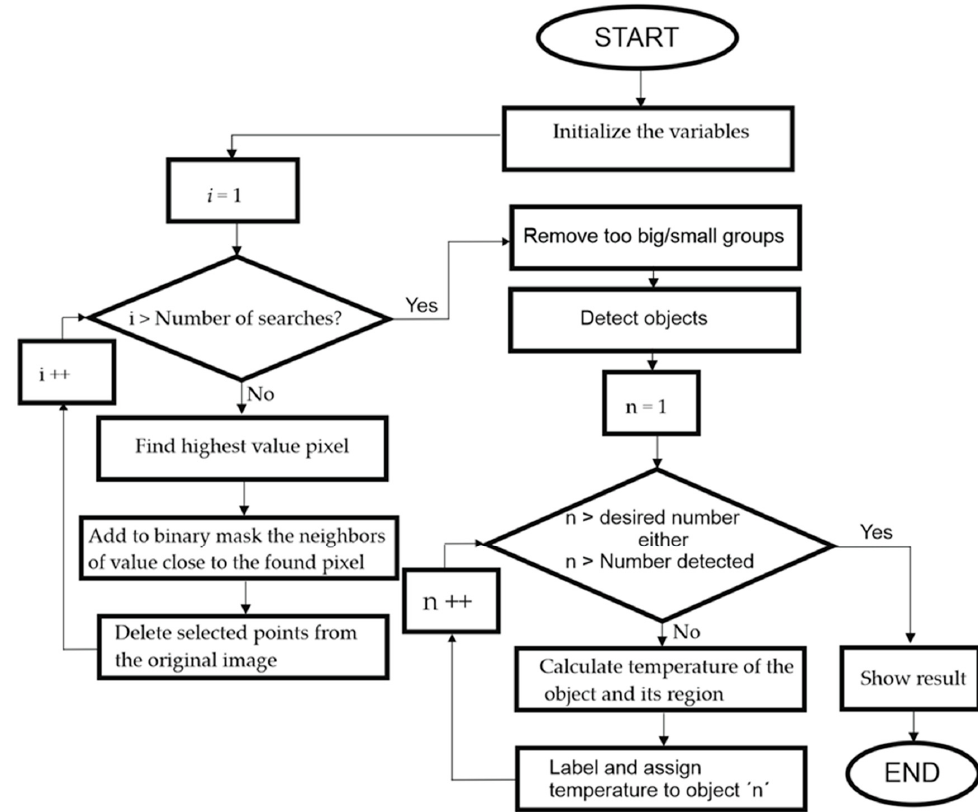
Figure 13. Diagram of execution of the hot-spot search and labelling algorithm.